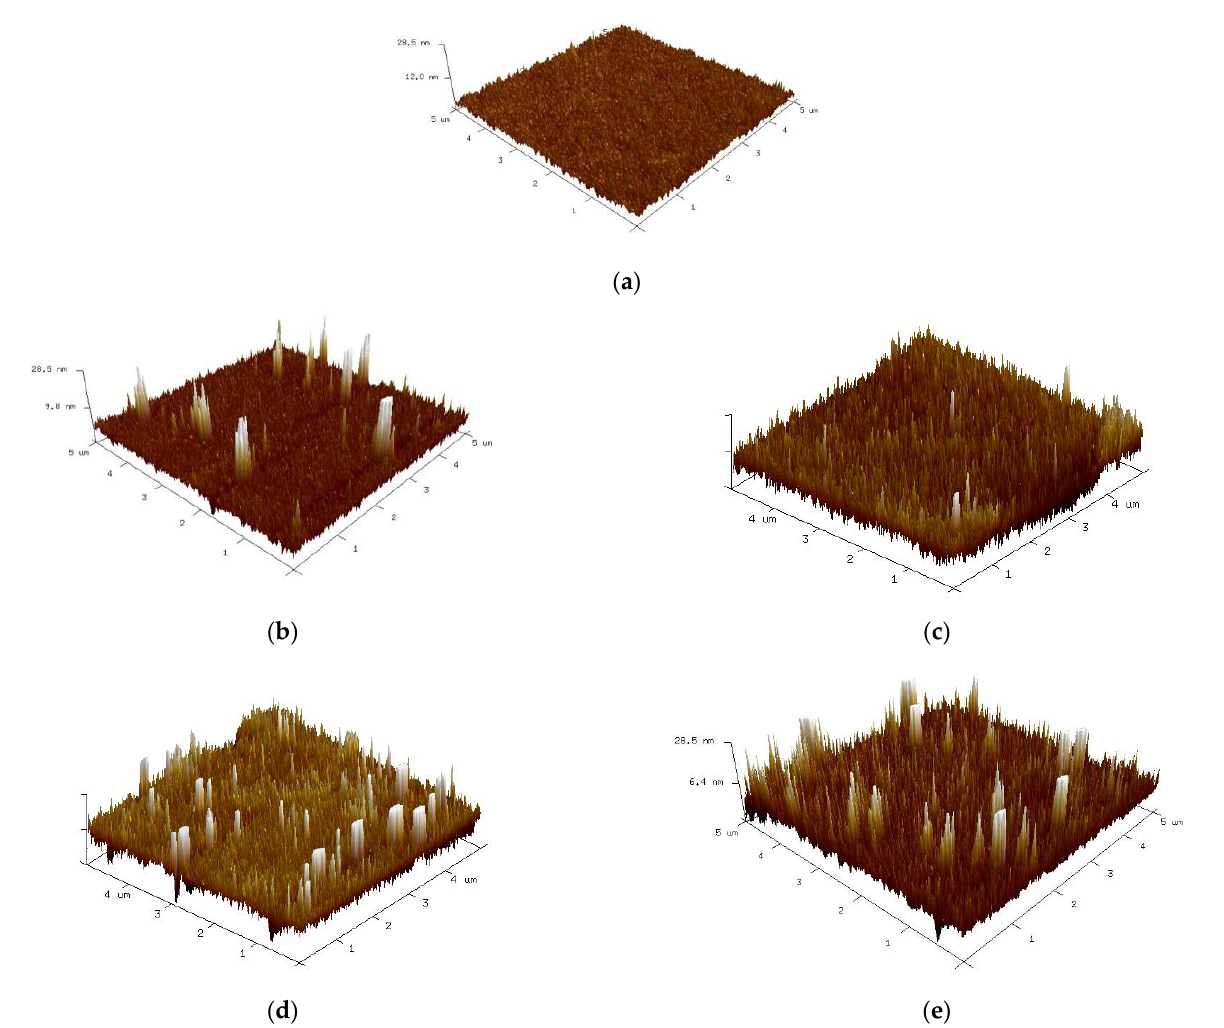
Figure 9. Three-dimensional surface contour diagrams of PI substrates: ( a ) untreated, and treated with different plasmas: ( b ) air, ( c ) Ar-5%H 2 , ( d ) N 2 -30%H 2 , ( e ) O 2 .